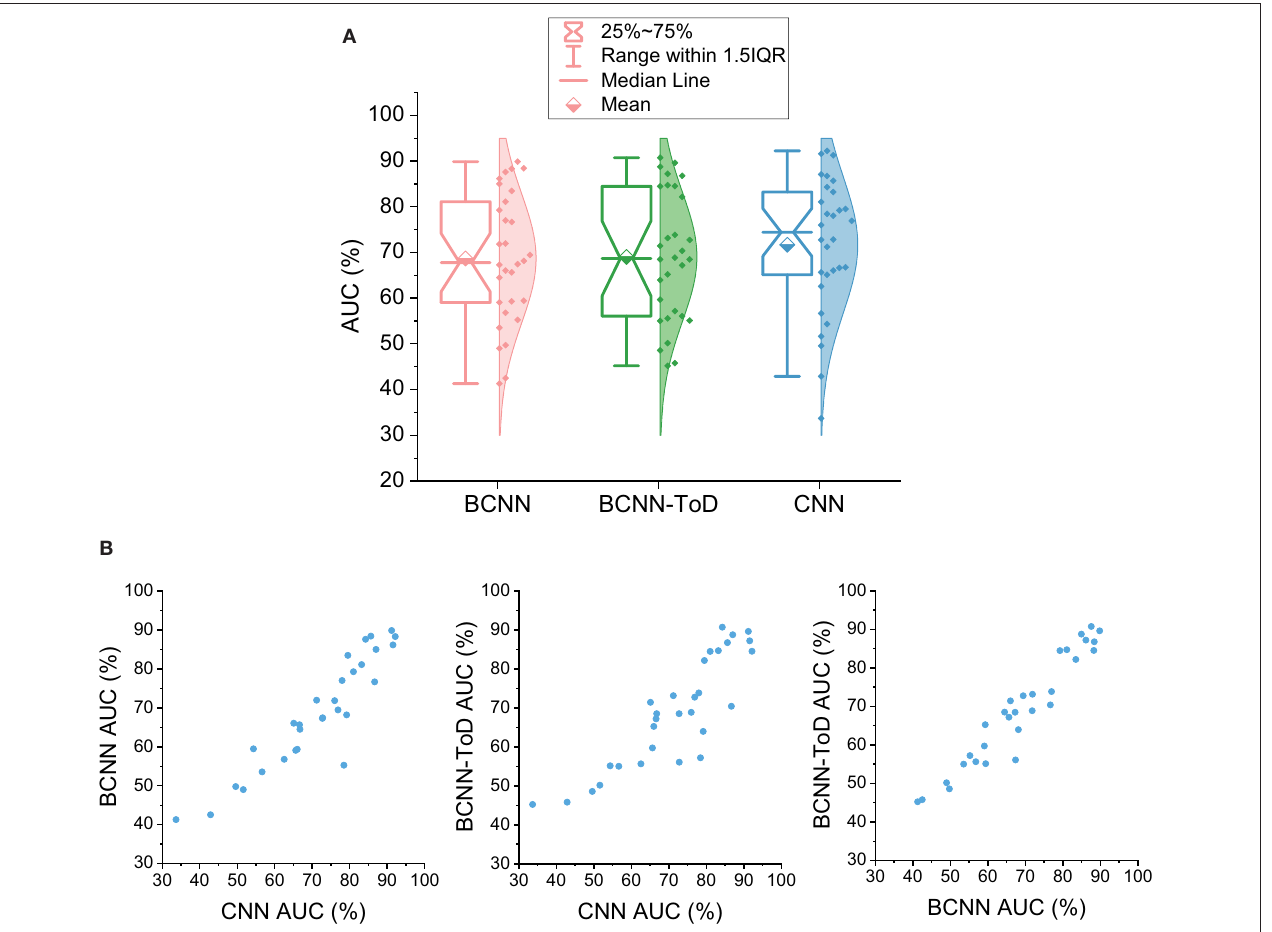
FIGURE 4 | (A) Seizure prediction performance using Bayesian convolutional neural network (BCNN). CNN, Convolutional neural network, average AUC is 71.64 % ; BCNN, BCNN using EEG signals only, average AUC is 68.69 % ; BCNN-ToD, BCNN using EEG signals and time-of-day (ToD), average AUC is 69.03 % . (B) Scatter plots between each pair of the three methods showing concordance between them.